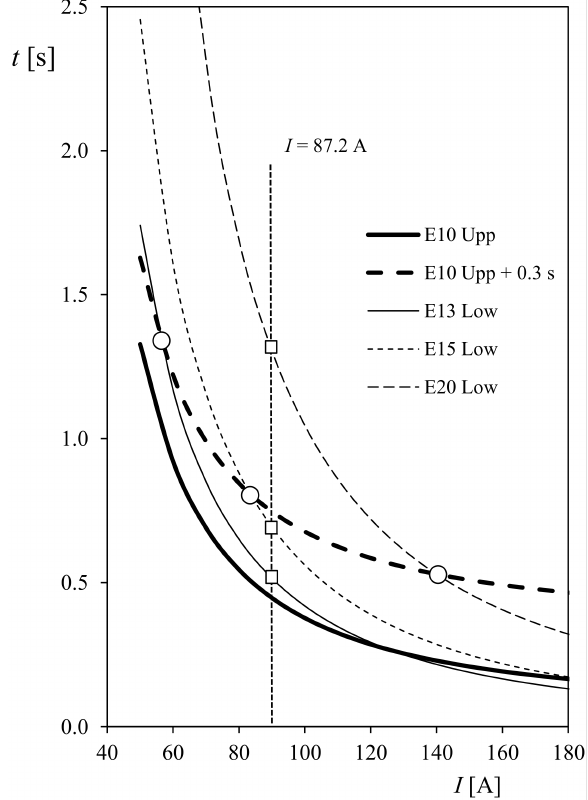
Figure 7. Selection of fuses to avoid the uncorrected coordination detected in case 23 of the calcu- lations considering PV nodes where the photovoltaic DG are installed. The upper tripping time curve, t ES , of SMD-50 E10 fuse selected for F4 fuse location (see Figure 6) is plotted, together with the lower tripping time curves, t EI , corresponding to SMD-50 E13, SMD-50 E15, and SMD-50 E20 fuses. The points of these curves corresponding to current I = 87.2 A obtained from the simulation of case 23 are indicated (open squares). The points corresponding to a proper coordination between fuse SMD-50 E10 as F4 with SMD-50 E13, SMD-50 E15, and SMD-50 E20 fuses as F3 are also indicated (open